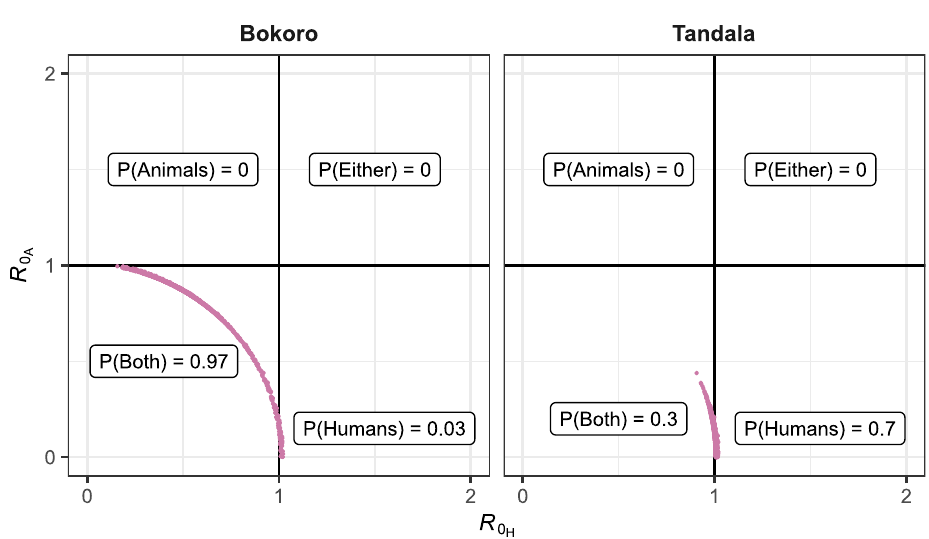
Fig 4. Basic reproduction number for animals ( R and Tandala, calculated for each of 2 000 posterior parameter sets of the model including animal transmission. The probability that transmission in animals only ( P ð Animals Þ ¼ P ð R